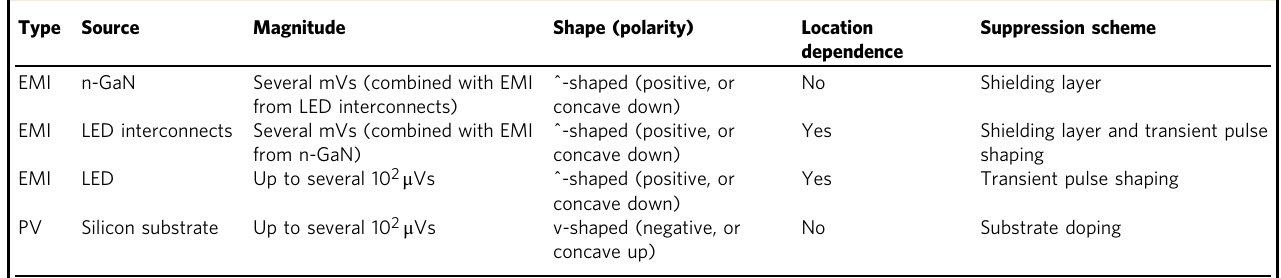
The magnitude of each stimulation artifact component was derived from the calculated difference in the magnitudes of the stimulation artifact measured from devices that did and did not utilize the suppression scheme indicated. The measurement of the stimulation artifact magnitude was made with μ LED irradiance of 75mWmm – 2 . The shape of the stimulation artifact indicates the shape observed in the recorded signal at the onset of the optical